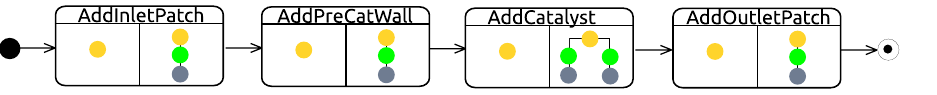
Fig. 12 The sub activity createCAD that attaches to each system component instance (yellow) the corresponding CAD instances for hosting the CAD parameters (green) and the CAD representation